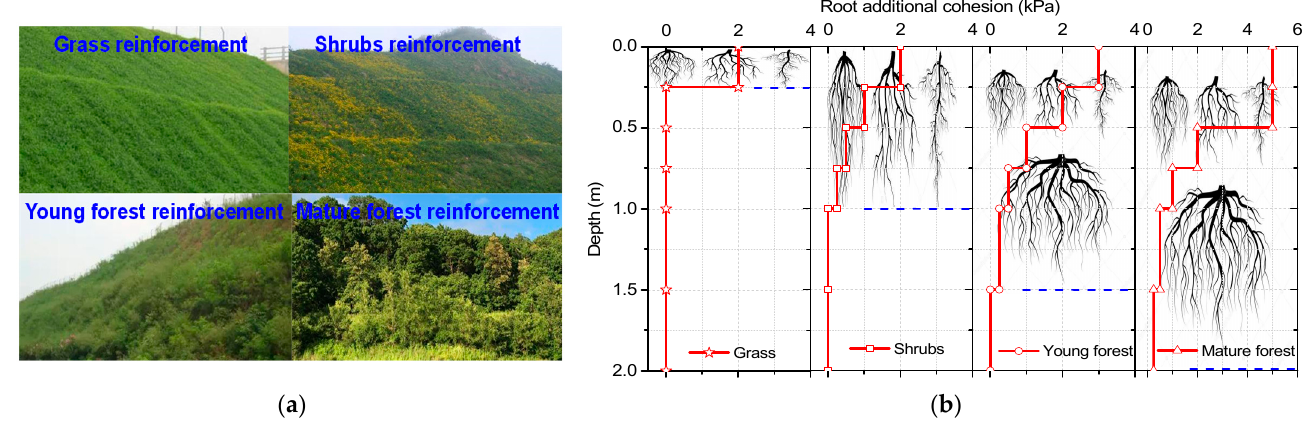
Figure 4. Root reinforcement: ( a ) four different vegetation; ( b ) Relationships between root additional cohesion and depth (modified from Kokutse et al. (2016)).